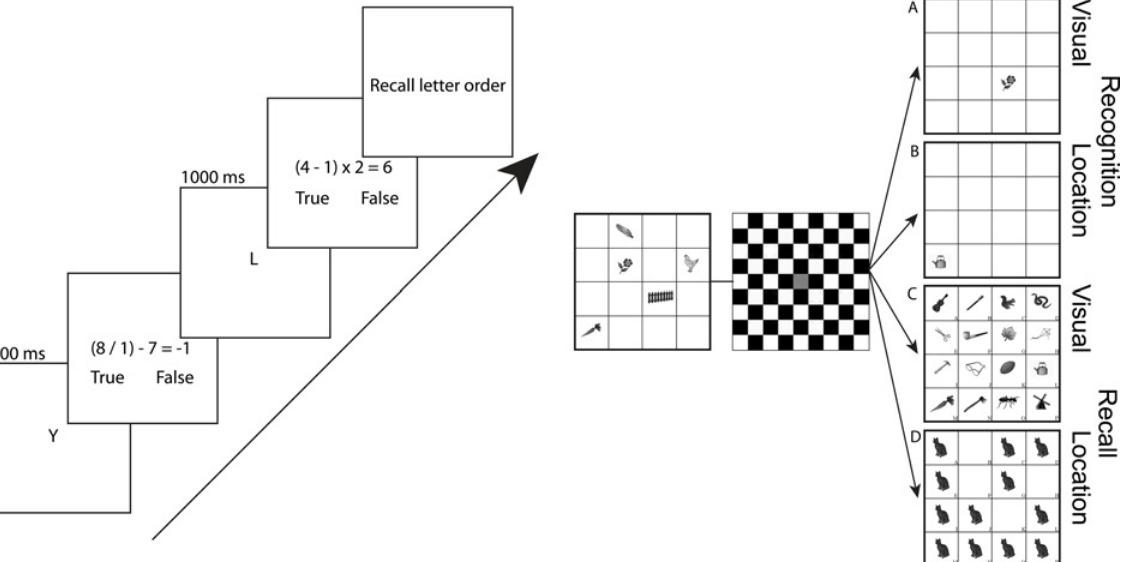
Fig 1. Left: OSpan WM paradigm. Participants remember consonants (1000 ms) then solve arithmetic problems before reporting the letter sequence. Right: Visuospatial WM paradigm. A) Visual recognition trials start with the presentation of the stimulus array (500 ms) followed by a delay period (750 ms) and the appearance of a probe item. Participants reported whether the probe item was ‘ old ’ or ‘ new ’ . B) Location recognition trials began with the stimulus array (200 ms) followed by a delay period (4000 ms). Participants reported whether the probe location was ‘ old ’ or ‘ new ’ . C) Visual recall trials begin with stimulus presentation (2000 ms) followed by a delay (500 ms). The probe array contained 15 new and 1 old item, which participants were asked to identify. D) Location recall trials begin with stimulus presentation (200 ms) followed by a delay period (4000 ms). At probe, an array of filled locations appeared and participants reported which filled location had been occupied at